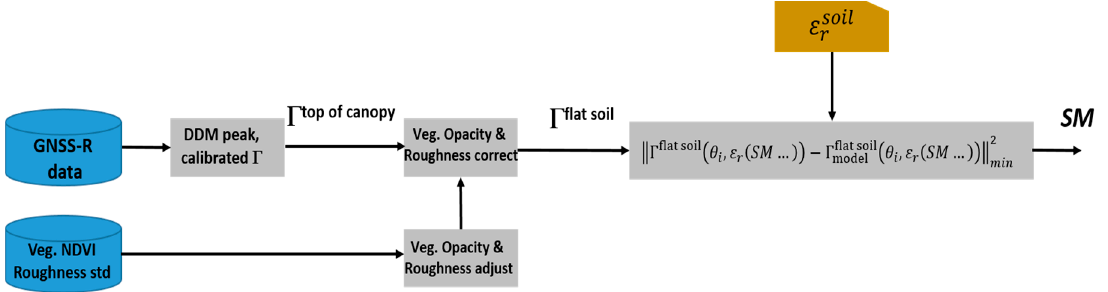
Figure 2. Volumetric SM retrieval algorithm workflow.